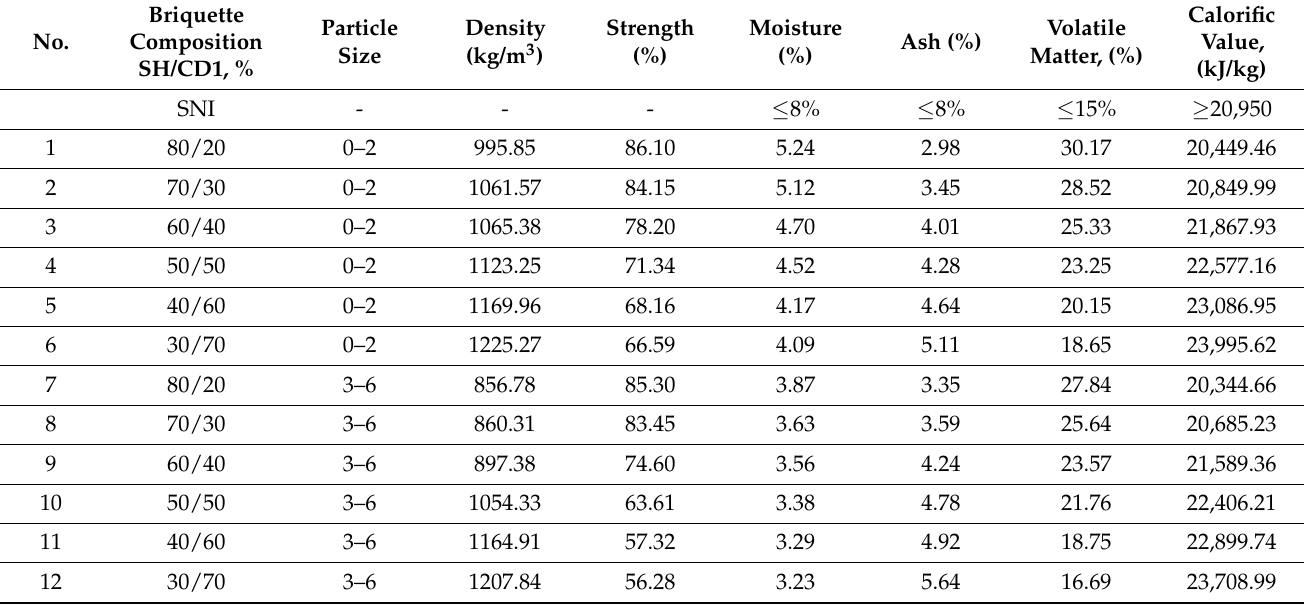
Table 6. The results of the analysis of briquettes (sunflower husk and coke